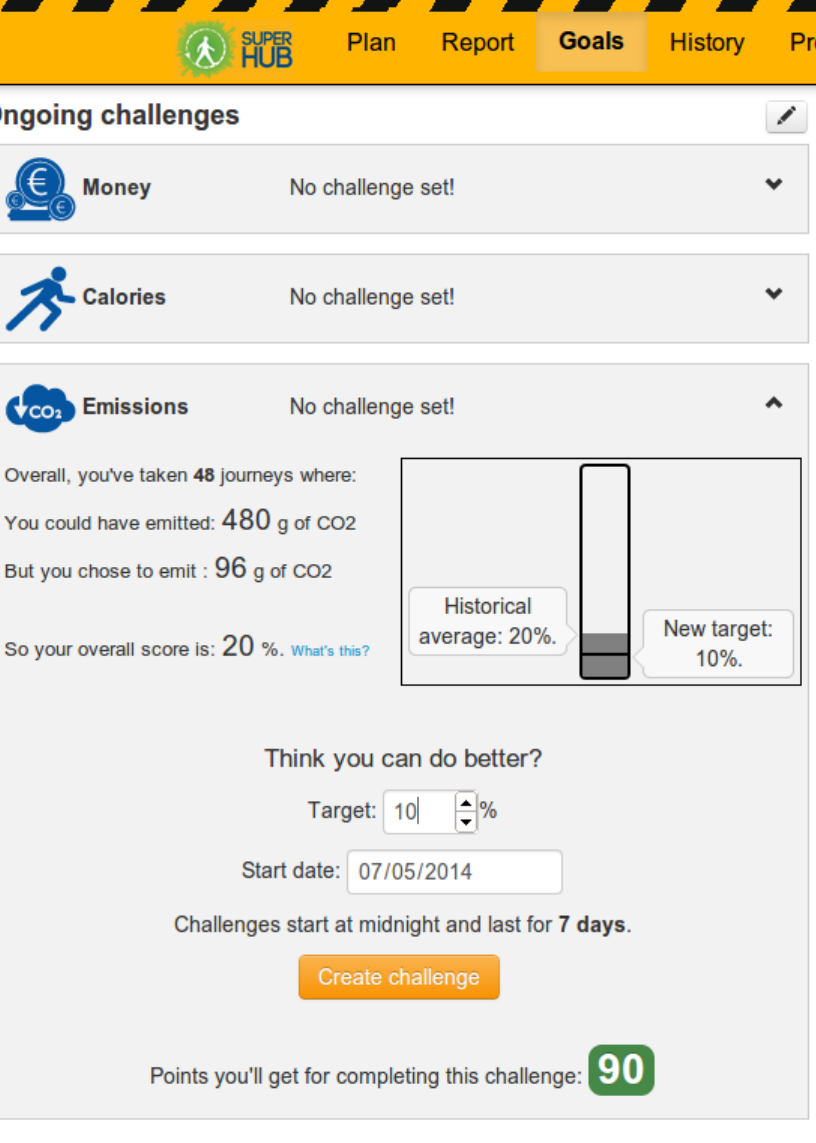
Figure 2. Challenge setting screen. User is shown the i) number of journeys they’ve taken, ii) amount of CO2 they could have emitted, iii) amount of CO2 they emitted by choice of journey plan, and iv) their resulting overall score/index. A bar/visual representation is also shown. As the users adjust the target for their challenge, the points promised for a successful completion is